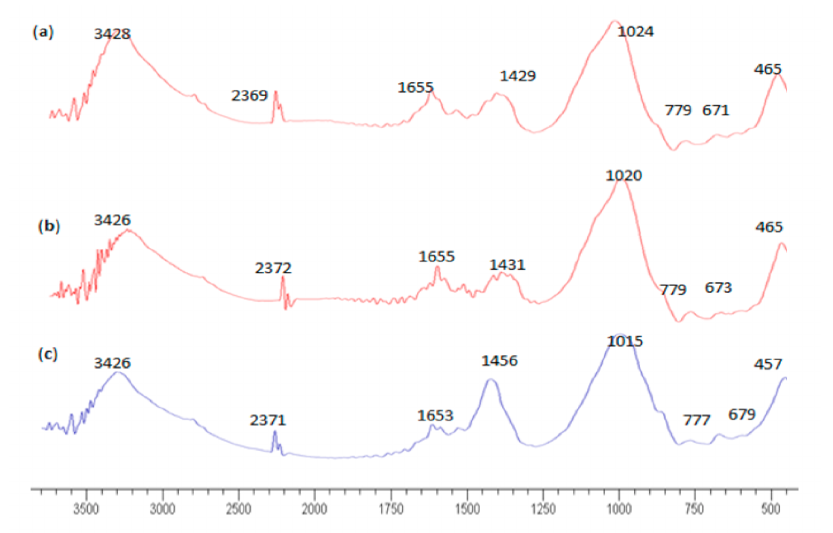
Figure 11. FTIR spectra for alkaline-activated POFA paste: ( a ) Na 2 SiO 3 /NaOH = 1.0, ( b ) Na 2 SiO 3 /NaOH = 2.5, and ( c )